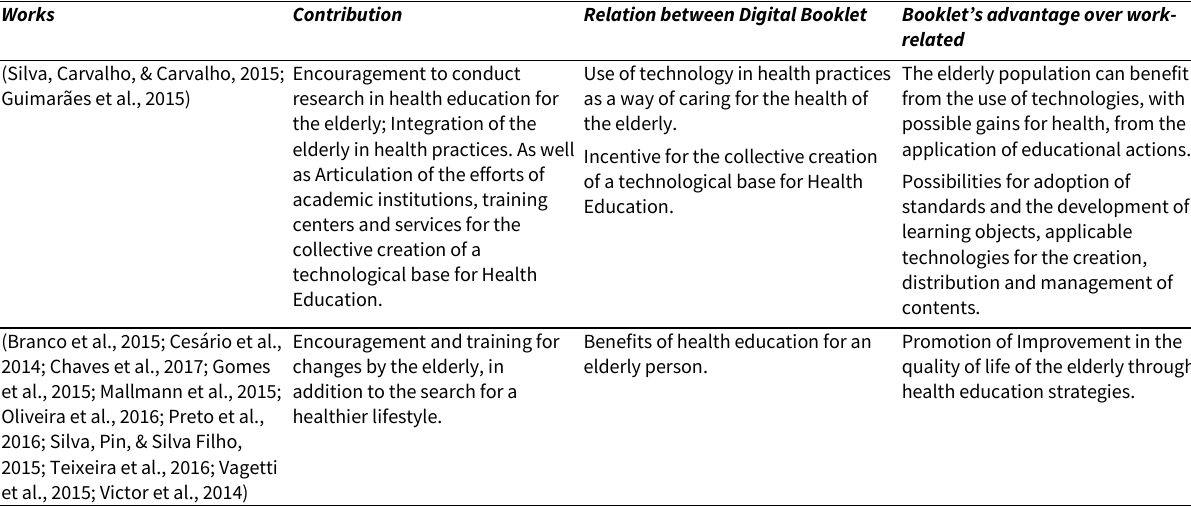
Table 1. Related works and the digital booklet